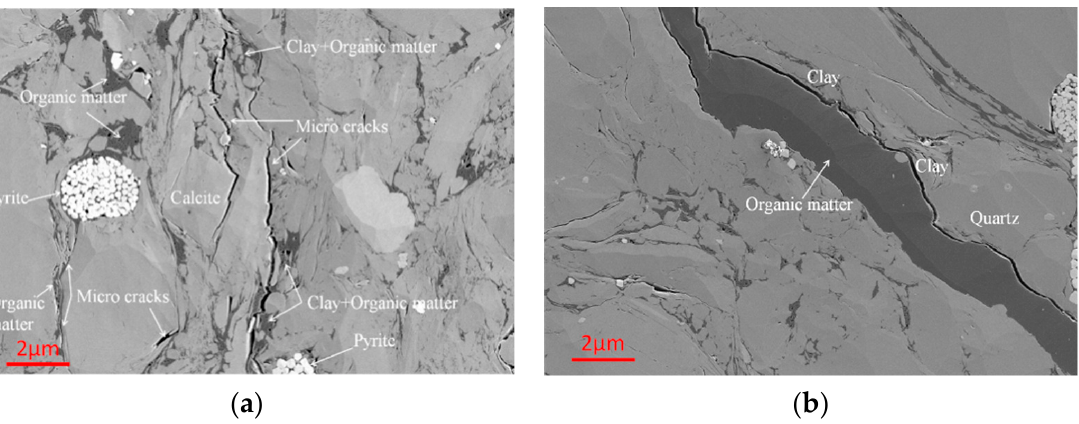
Figure 4. Typical images of microcracks developing ( a ) along the boundaries of mineral grains and ( b ) organic matter.